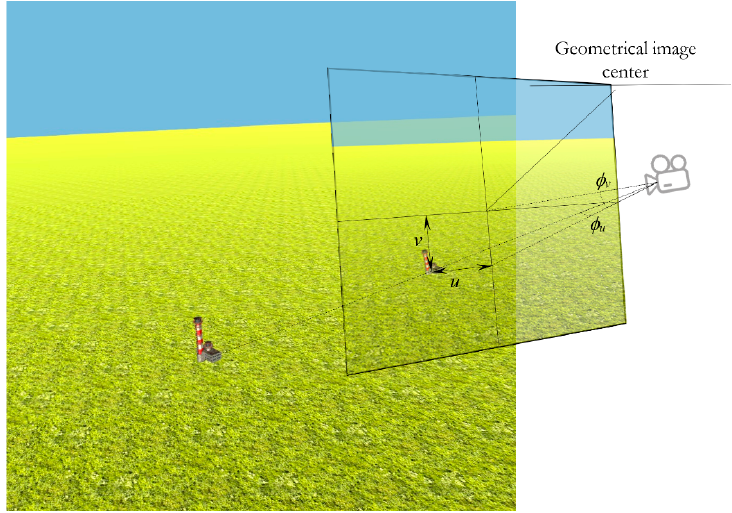
Figure 6. Homography transformation for translation of the object origin projection to the image center.